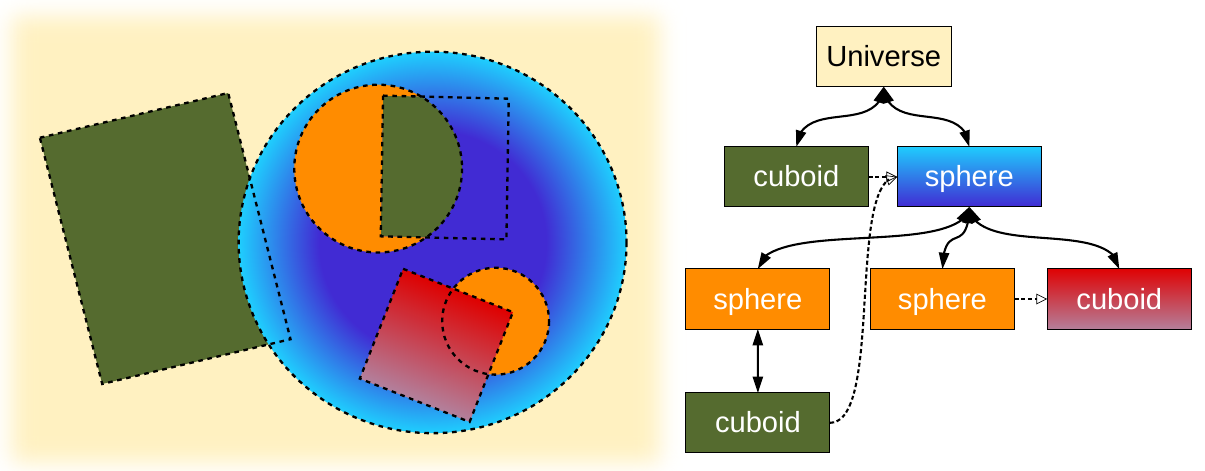
Figure 3. An example environment composed of di ff erent volumes with di ff erent physical properties indicated by color (left). In the implementation, these are assembled in a tree structure